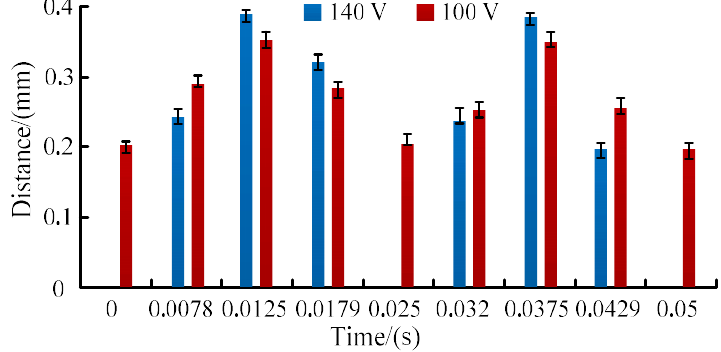
Figure 7. The distances of CVLSs.